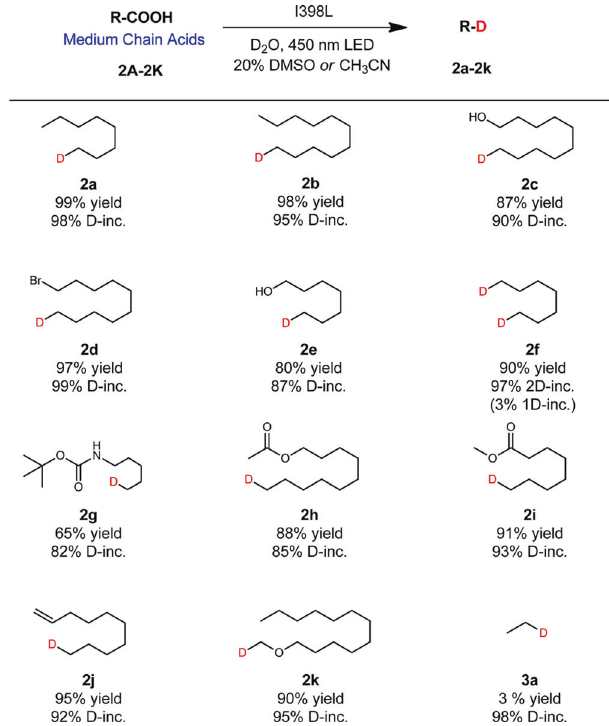
Fig. 3 Deuteration scope: medium chain acids. Reaction conditions: Substrate (0.40 mmol), crude enzyme powder (containing Cv FAP about 20 mg), D 2 O (8 mL), DMSO or CH 3 CN (2 mL), 450 nm LED, 20 °C, 12 h. Yields were determined by GC. D-inc. data were determined by 1 H NMR or HRMS.